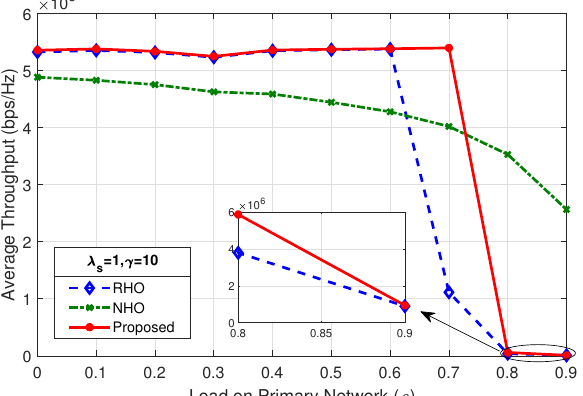
Figure 13. Average throughput of the system for λ s = 1, γ = 10.